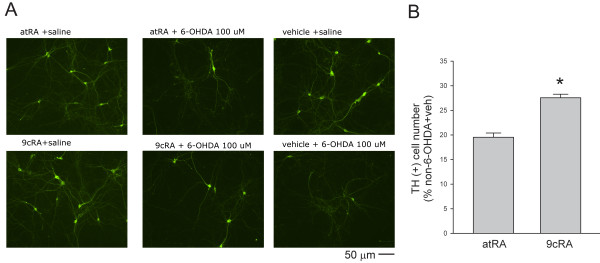
9cRA is more effective than atRA against 6-OHDA –mediated neurodegeneration in VM TH neurons. (A) Primary VM neuronal cultures were treated with either 6-OHDA (100 μM) or saline for two hours and then were treated with either 9cRA or atRA (50 nM). 9cRA, compared to atRA, is more potent in protecting against 6-OHDA –mediated loss of TH cells). (B) 9cRA (50 nM) is significantly effective than atRA (50 nM) to increase survival of TH cells after lesioning with 6-OHDA (100 μM). The density of TH (+) cells was normalized to the cell density in the non-6-OHDA and non-9cRA (vehicle) -treated group. More TH neurons survived after treatment with 9cRA+ 6-OHDA, compared to atRA + 6-OHDA (*p<0.001).